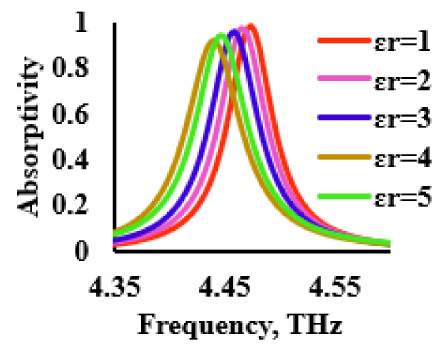
Figure 12. Performance of the THz sensor for various dielectric